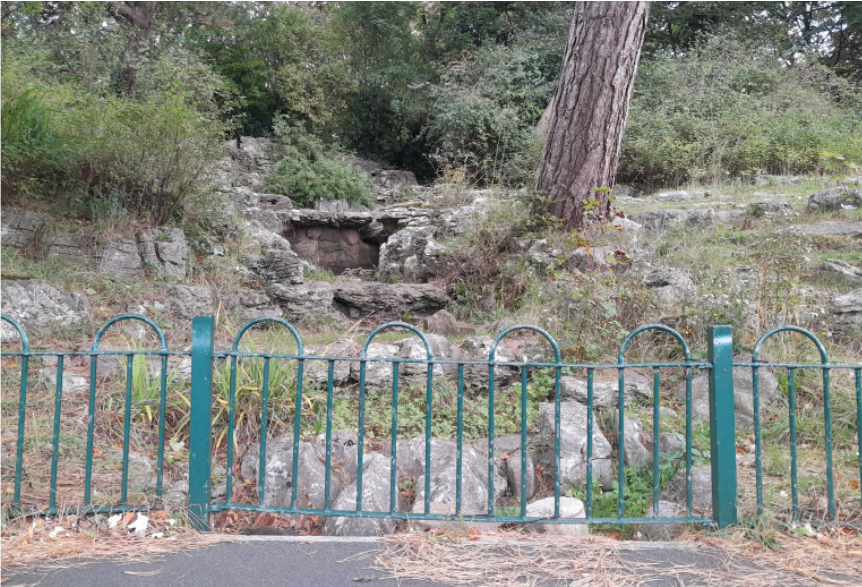
Figure 3. A landscape reconstructed – representation of limestone pavement and a dry valley in Hesketh Park,